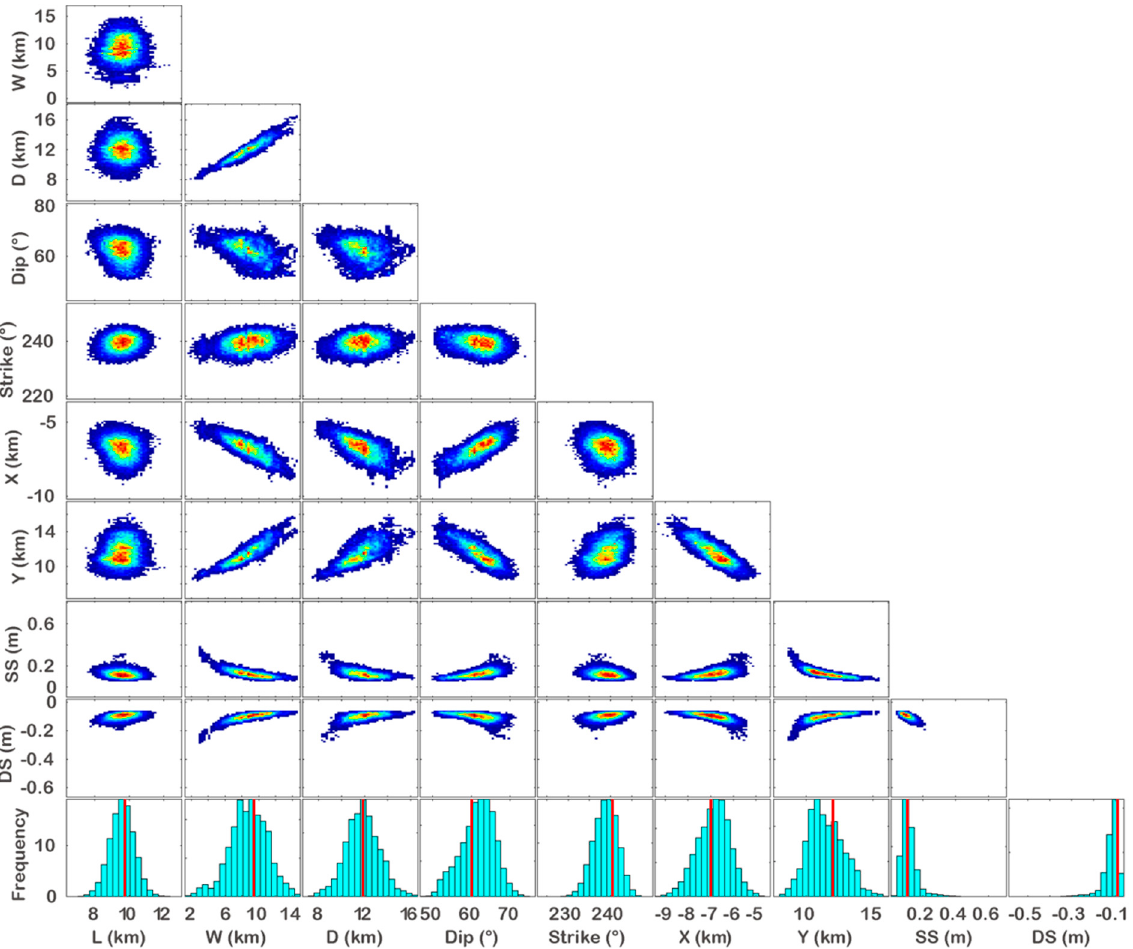
Figure 4. Marginal posterior probability distributions for the source parameters for the 2021 Nagqu Mw 5.7 earthquake. Scatter plots are contoured according to frequency (warm and cold colors for high frequency and low frequency, respectively). Red lines represent the maximum-a-posteriori probability solution (see also Table 1).